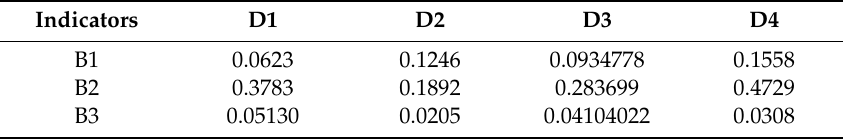
Table 8. Weighted normalized decision-making matrix.